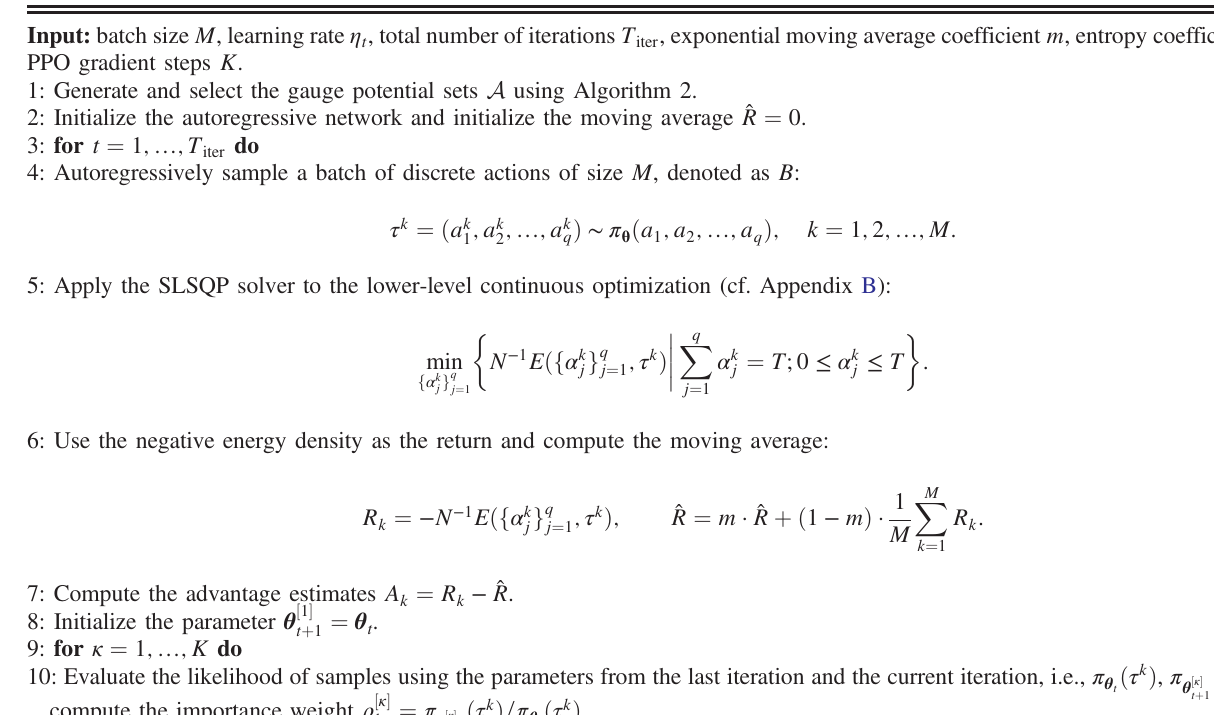
Algorithm 1. CD-QAOA with autoregressive network based